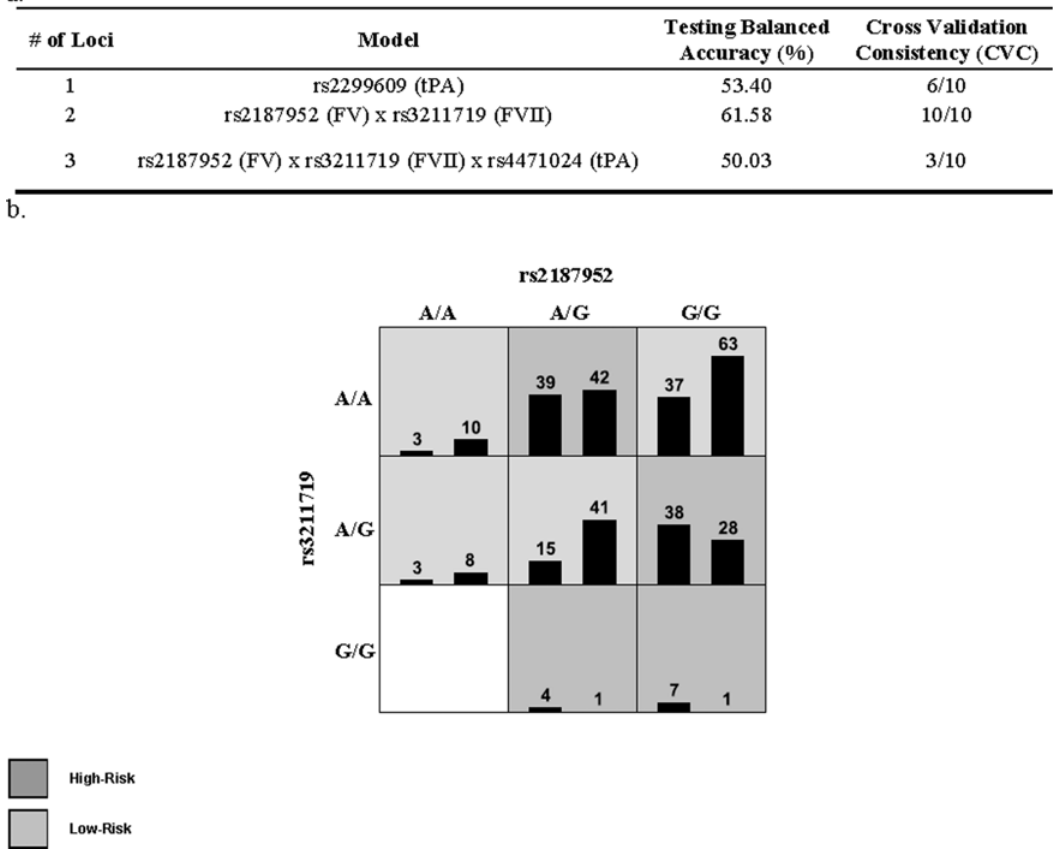
Figure 1. MDR complement and coagulation two locus model between FV and FVII. a . Testing accuracy and cross validation consistency for the best one to three locus models. b . Best multilocus model in the complement and coagulation pathway - Each multifactor cell is labeled as ‘‘high risk’’ or ‘‘low risk’’. For each multifactor combination, hypothetical distributions of cases (left bar in cell) and controls (right bar in cell) are shown. Each cell represents a multilocus genotype; the genotype is labeled on the figure. The testing average balanced accuracy is 61.58% (p- value , 1.00 6 10 2 3 ) with a cross-validation consistency of 10/10. Logistic regression analyses showed that the interaction for the effects of these two markers was statistically significant (p=0.009) and the likelihood ratio test p value for including the interaction in the logistic regression model was 0.0072.